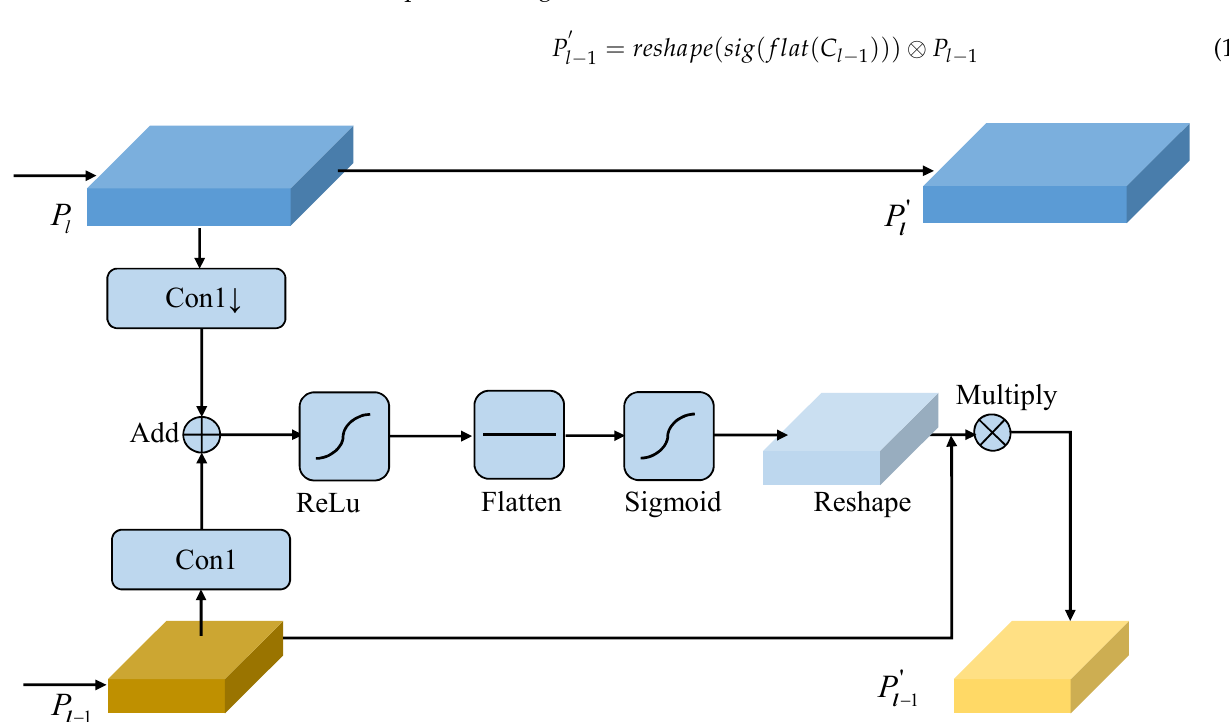
Figure 5. The procedure of attention-aware lightweight feature pyramid